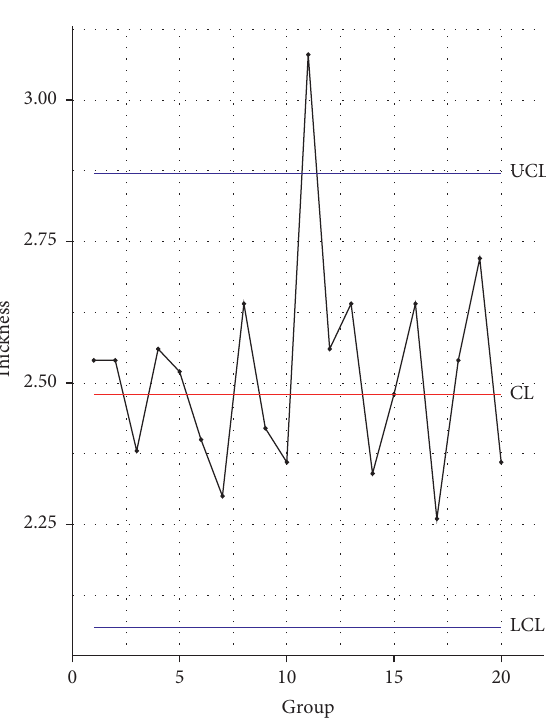
Figure 3: Skewness correction X control chart.